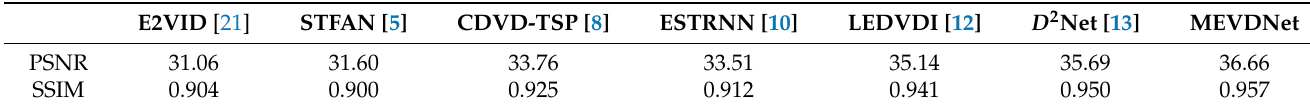
Table 2. Quantitative results of video deblurring using the GoPro synthetic dataset.